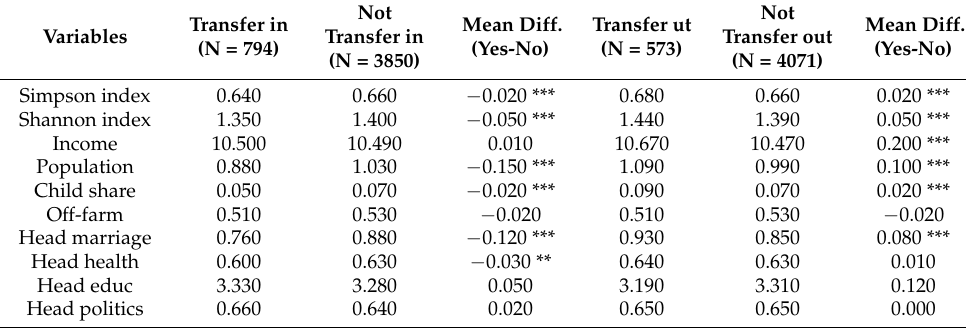
Table 2. The characteristic differences among